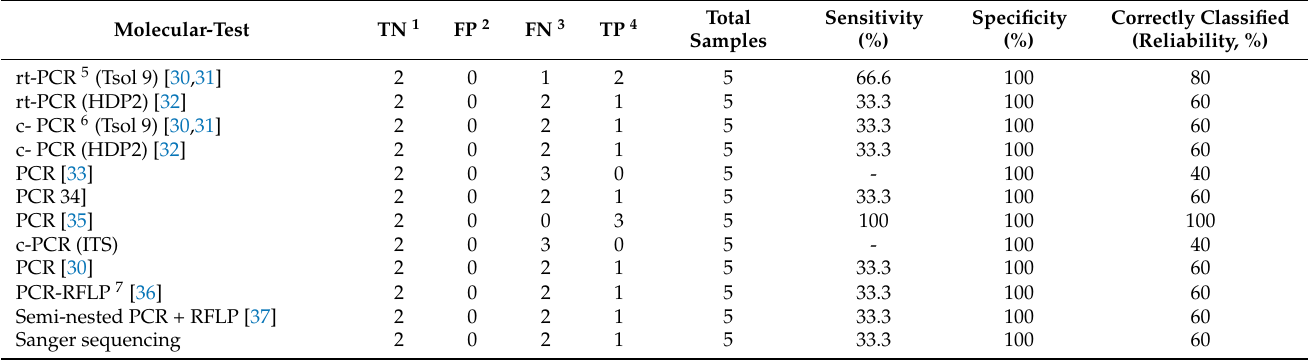
Table 12. Diagnostic performance by test of the molecular copro-Ring Trial.